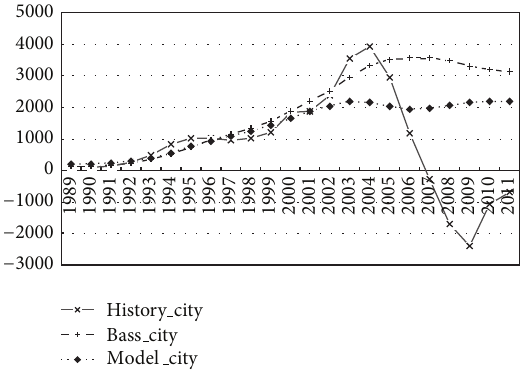
Figure 12: Plots of the diffusion rate of telephone in urban area by model (69) or model (70).